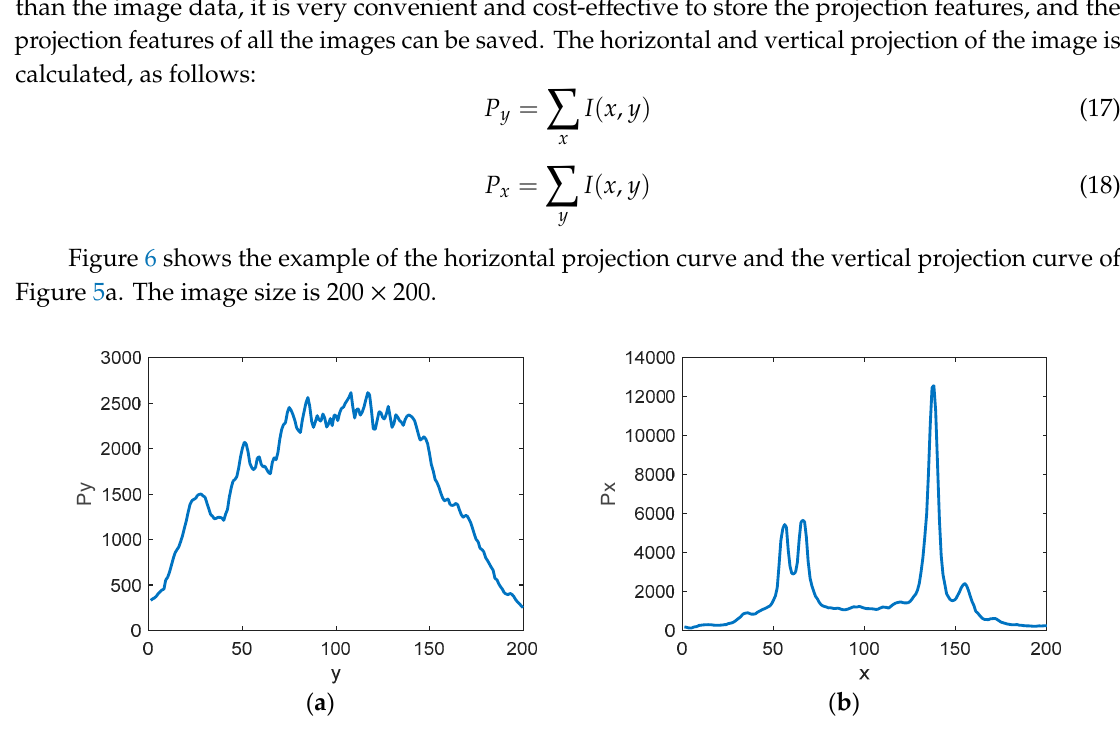
Figure 6. Example of the horizontal projection curve and the vertical projection curve of Figure 5a. ( a ) Horizontal projection curve; ( b ) Vertical projection curve.